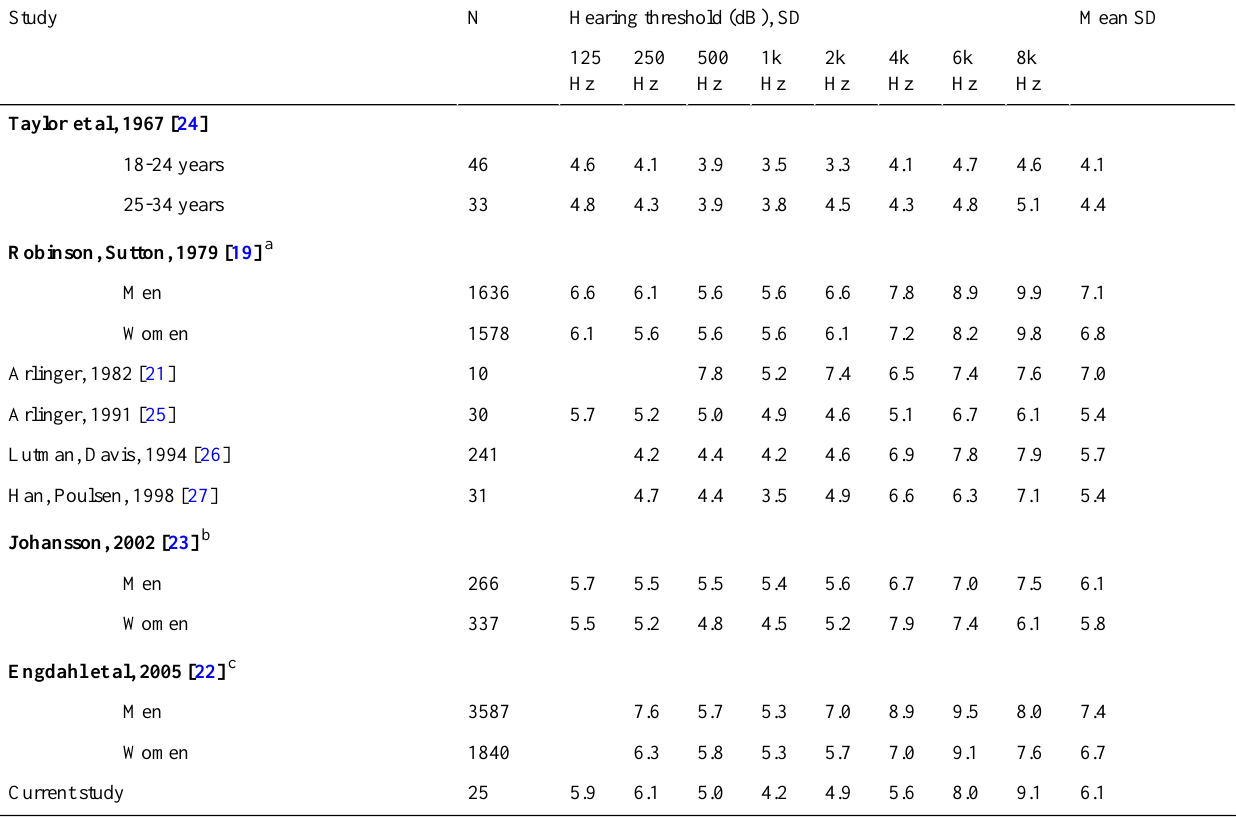
Table 6. Summary of standard deviations of the hearing threshold in decibels for participants with normal hearing in the literature.